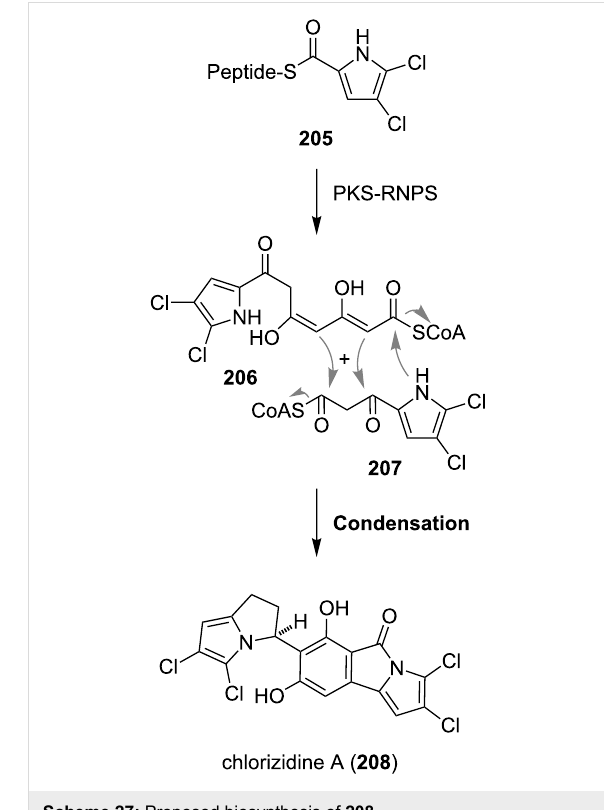
Scheme 27: Proposed biosynthesis of 208